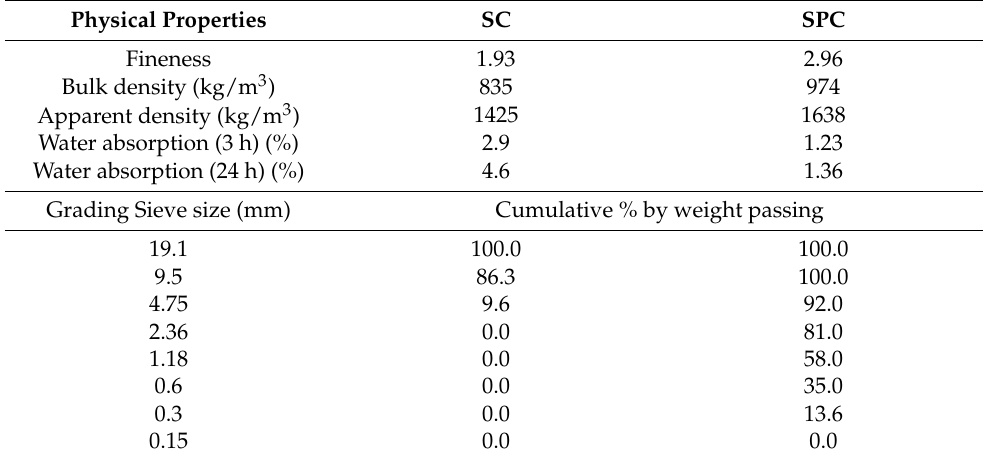
Table 1. Physical properties of the aggregates.